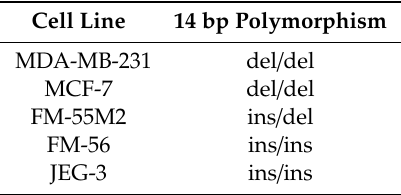
Table 1. HLA-G 14 bp insertion / deletion (ins / del) 3 (cid:48) UTR polymorphism in the cancer cell